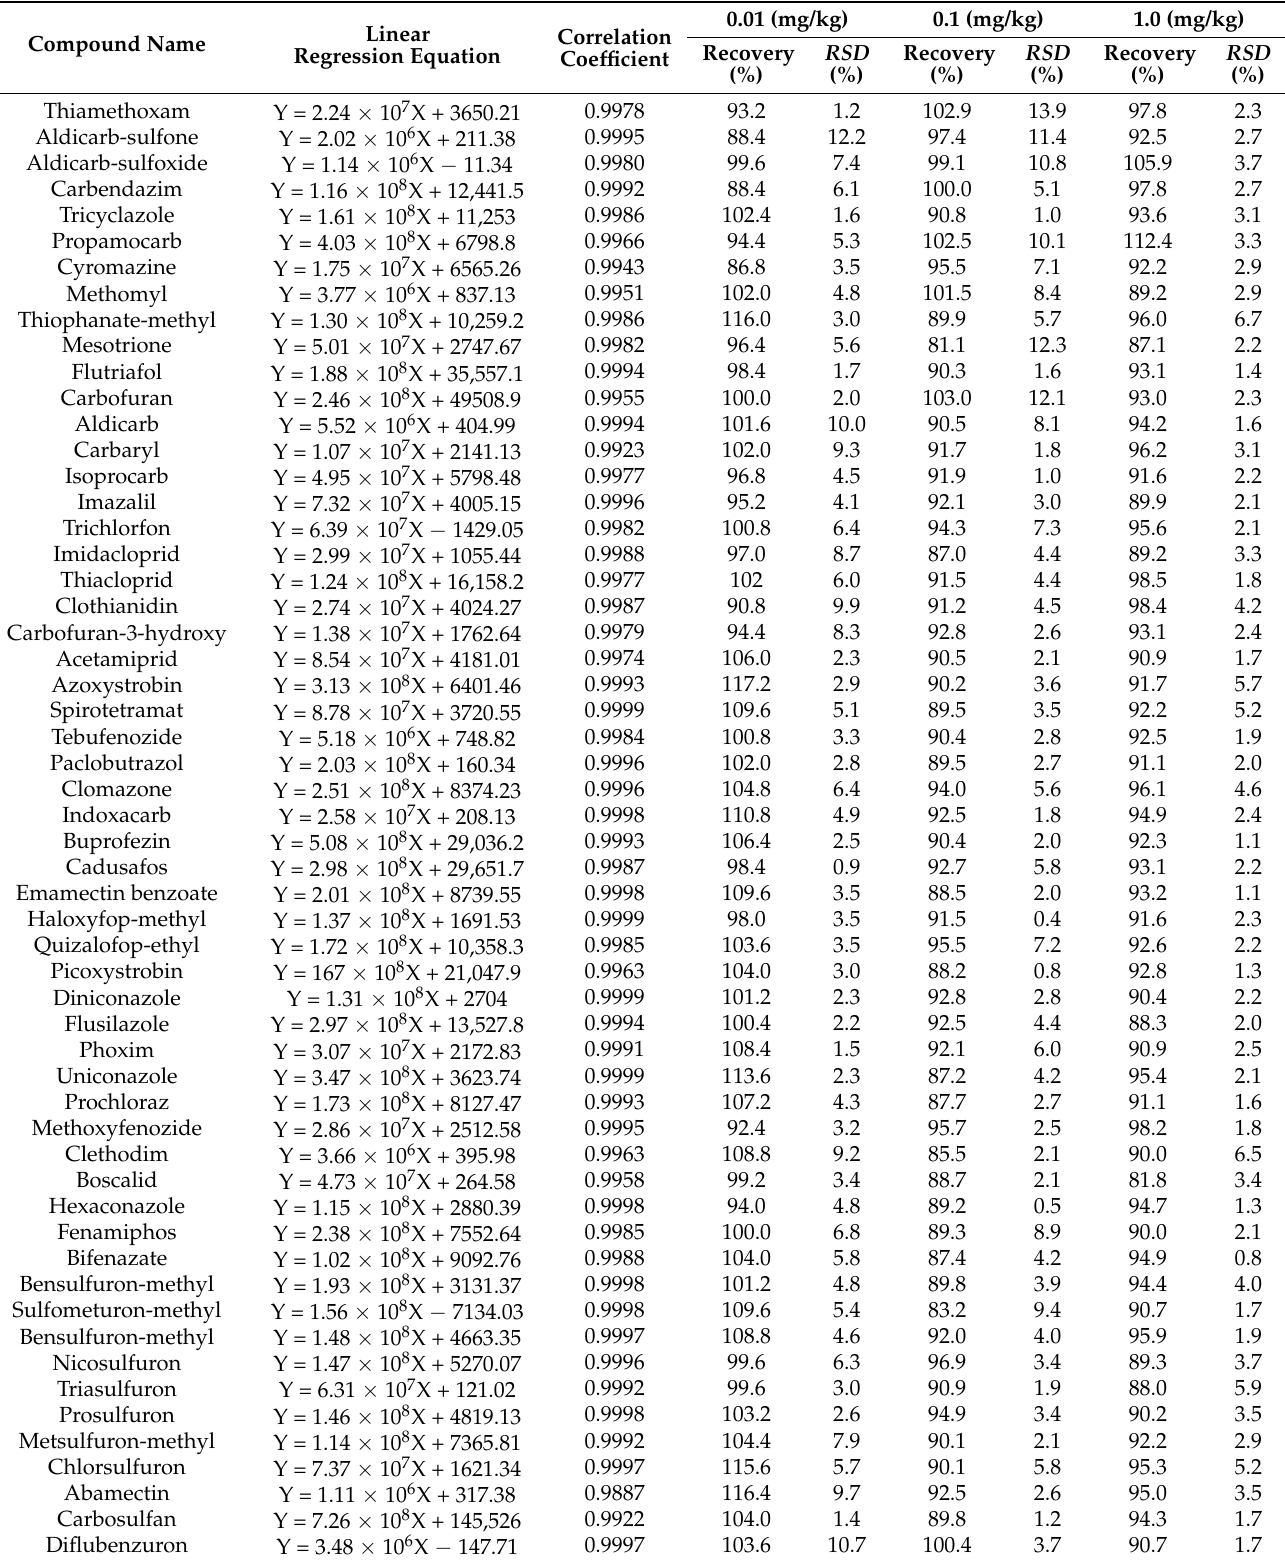
Table A3. The linear regression equation, recovery and precision for 56 pesticides analyzed by